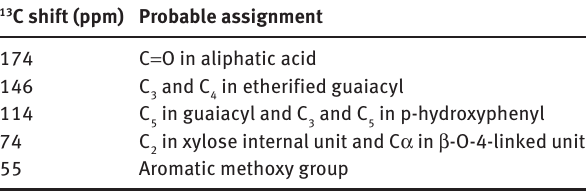
Table 2: Solid-state 13 C NMR spectroscopy